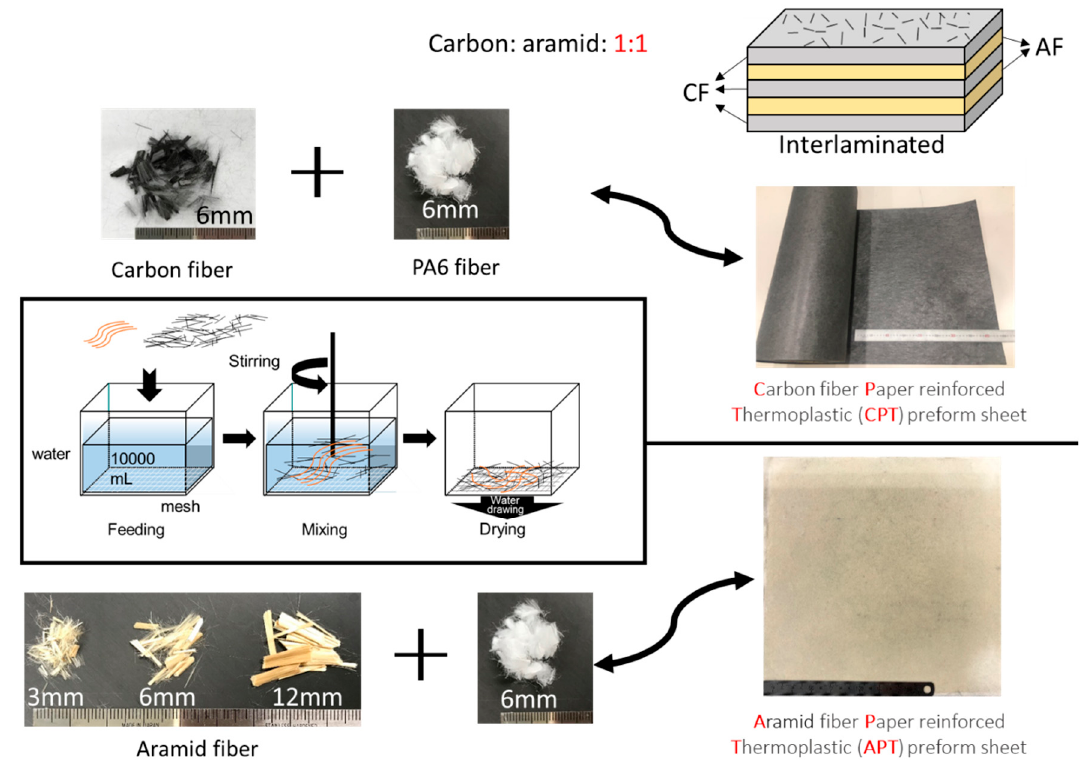
Figure 16. Diagram showing the features of CPT sandwich hydride toughened with aramid fiber paper.